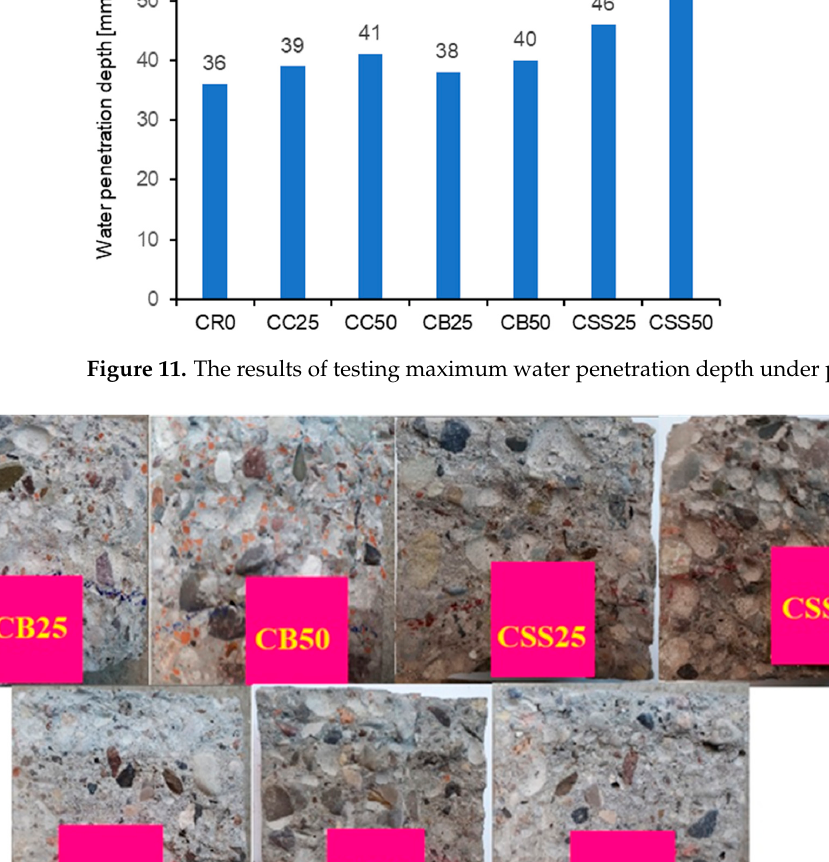
Figure 14. The average values of volumetric specific heat of the tested composites. The highest thermal diffusivity, a , has been registered for the reference concrete CR0, where the average value of a was 1.19 × 10 − 6 m 2 /s, which is higher by 10% than in the case